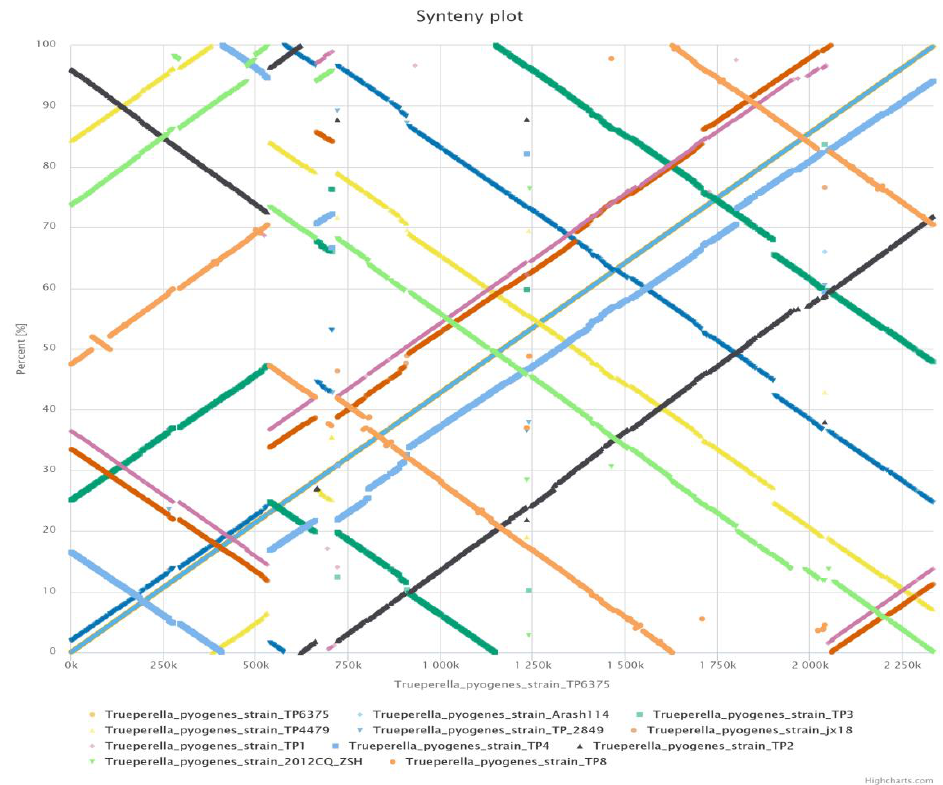
Figure 6. Synteny plot visualization of 10 complete T. pyogenes genomes compared against reference genome T. pyogenes TP6375 by the EDGAR webserver.